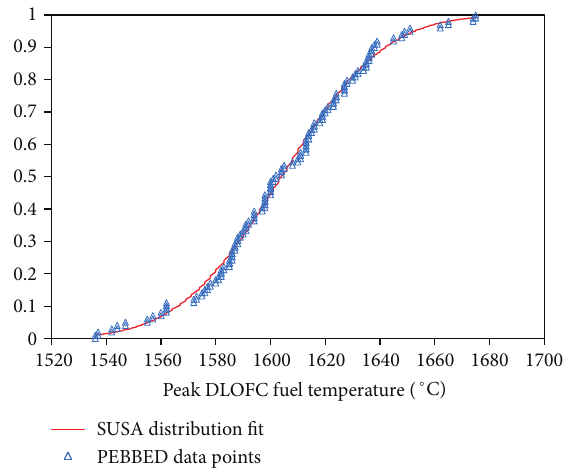
F 11: PDF and �tted normal distribution results for the 100 LHS Normal set: �-S level of signi�cance � 0.9919.